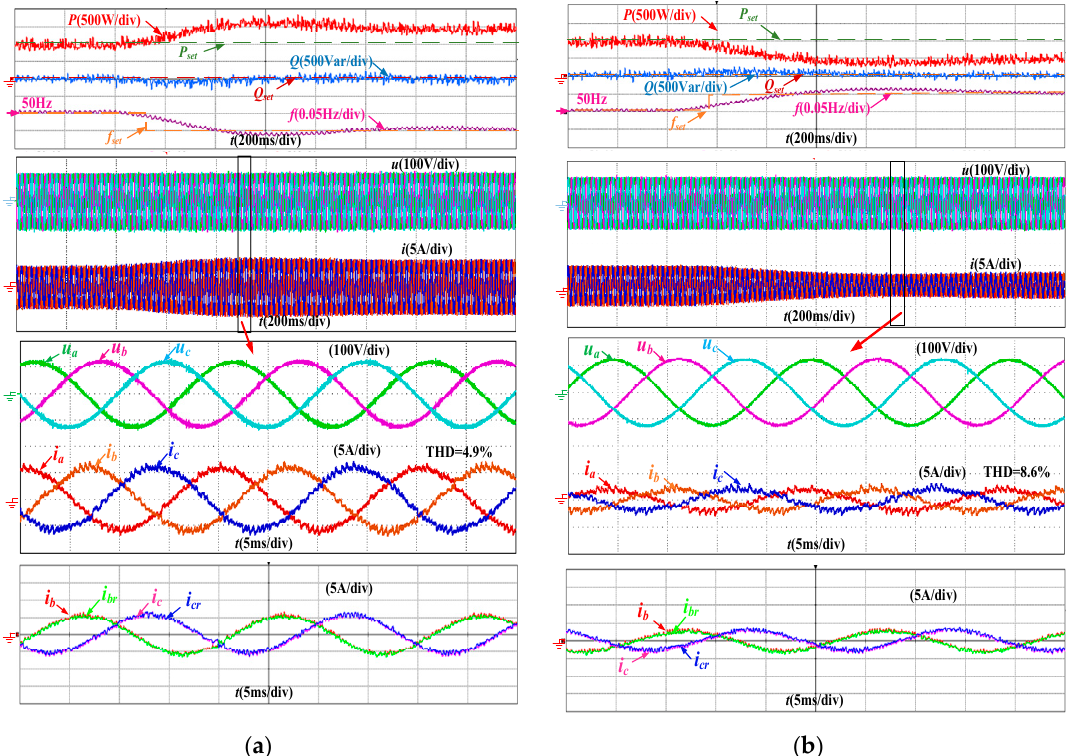
Figure 12. Experimental waveform of active power with frequency regulation (from top to bottom: reference and actual active power P set , P , reference and actual reactive power Q set , Q , reference and actual frequency of VSG f set , f ; grid voltage u a , u b , u c , grid current i a , i b , i c ; reconstructed and actual current of phases B and C i br , i cr , i b , i c ): ( a ) the grid frequency drops of 0.05 Hz; ( b ) the grid frequency increases of 0.05 Hz.